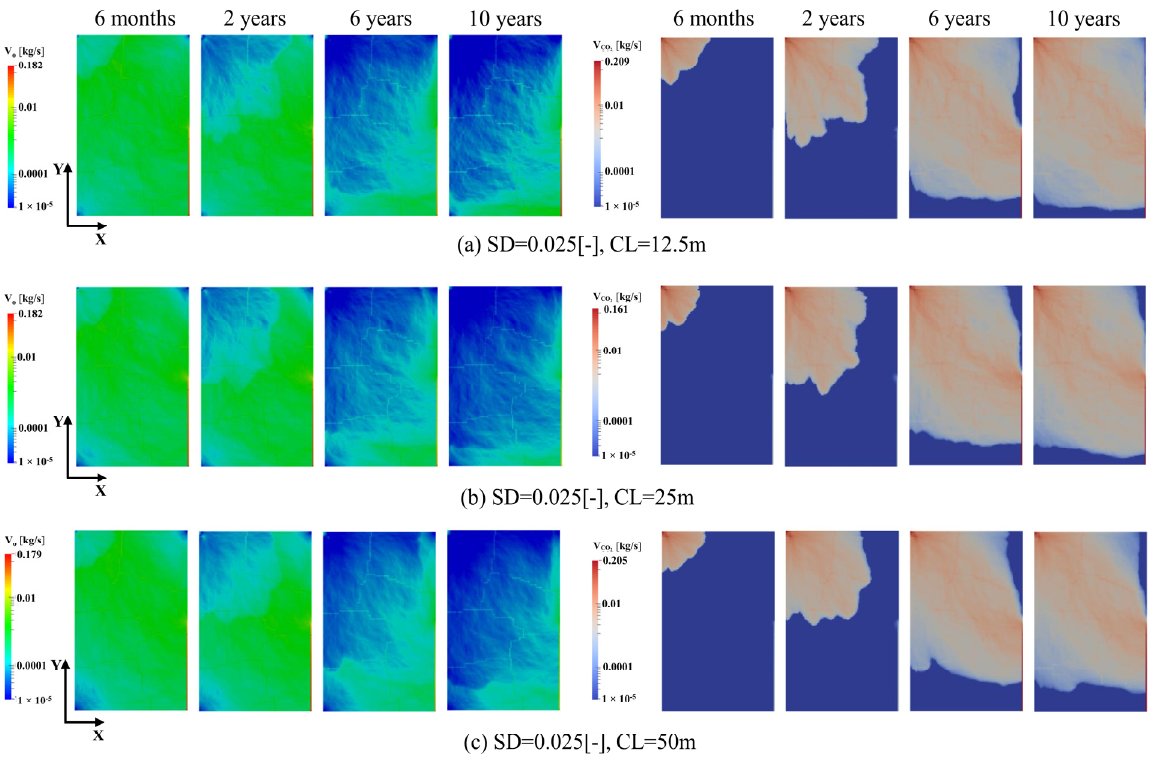
Figure 12. Evolutions of oil and CO 2 flow fields of Set 1. ( a ) SD = 0.025 (-), CL = 12.5 m; ( b ) SD = 0.025 (-), CL = 25 m; ( c ) SD = 0.025 (-), CL = 50 m.